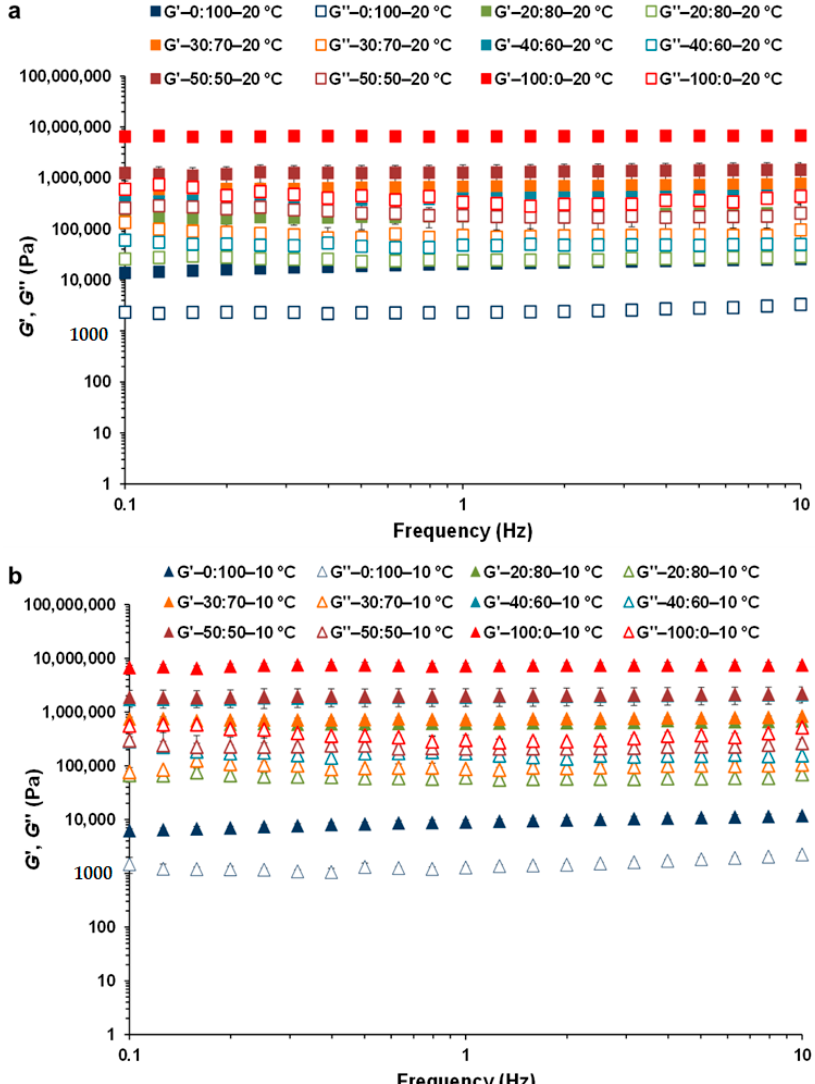
Figure 2. Storage modulus ( G ': filled symbols) and loss modulus ( G ": open symbols) as a function of oscillation frequency for the different formulated CB:OG systems: ( a ) at 20 °C; ( b ) at 10 °C. At 20 °C, and in the 6 formulated CB:OG systems, the G ' value is higher than that of